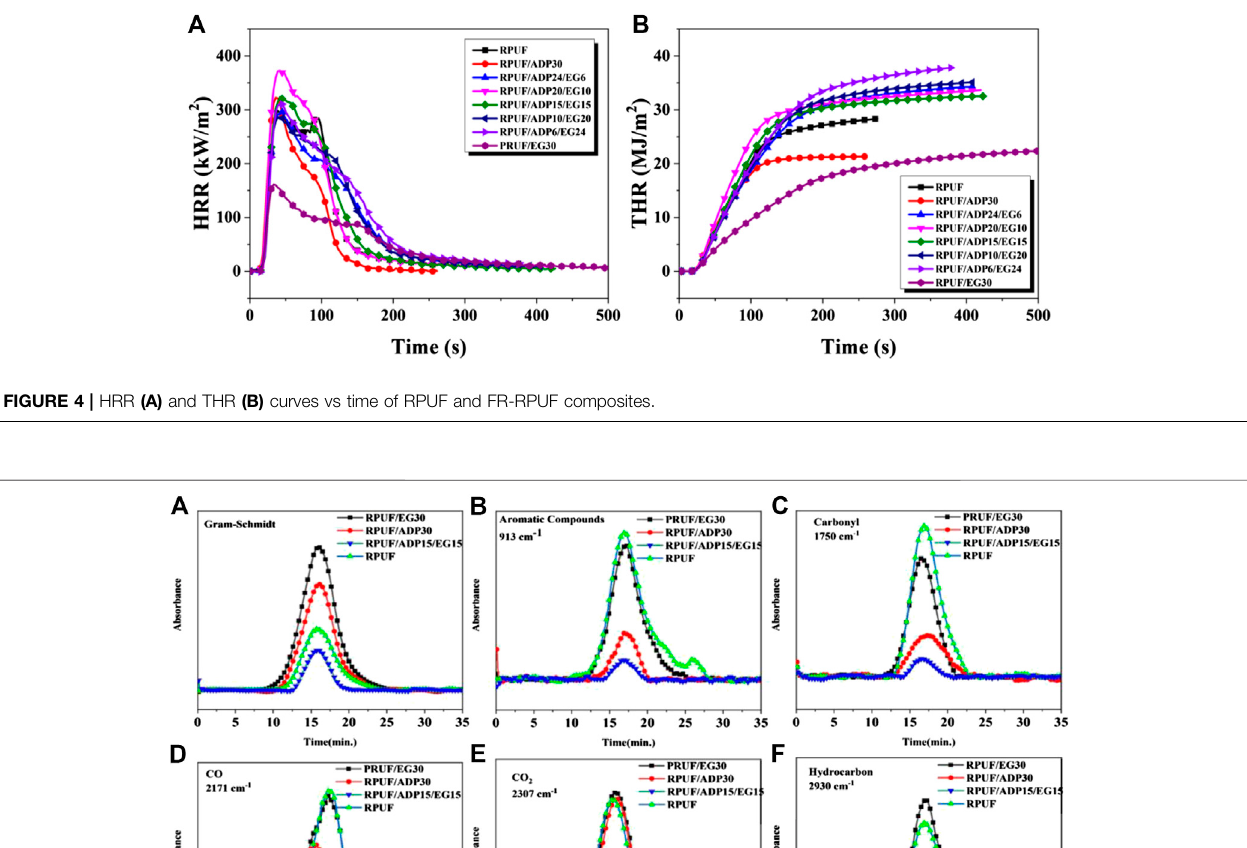
Frontiers in Materials |